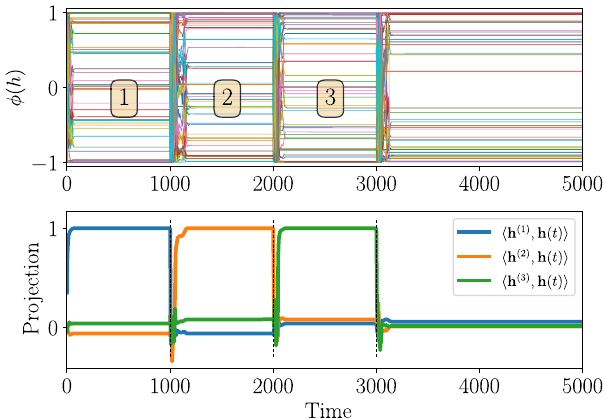
FIG. 6. Gates provide a reset mechanism. Positive static inputs are applied to the z gate when the RNN is in the marginally stable 3 . 0 , α 2 . 5 , and α ∞ Þ for 20 time units at times state ( g h ¼ r ¼ z ¼ indicated by dashed lines. The input induces chaos which rapidly scrambles the network state, thus erasing the trace of the previous memory; the bottom panel shows the normalized projection of the state h ð t Þ on the directions h ð 1 ; 2 ; 3 Þ aligned with the state in regions 1, 2, and